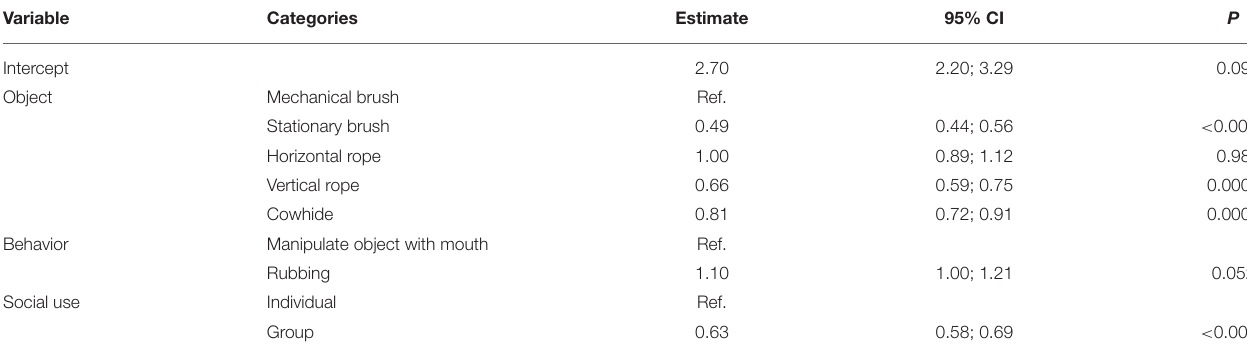
TABLE 3 | Final conditional mixed Poisson model for factors associated with the frequency of object usage ( n = 4,195s bouts).